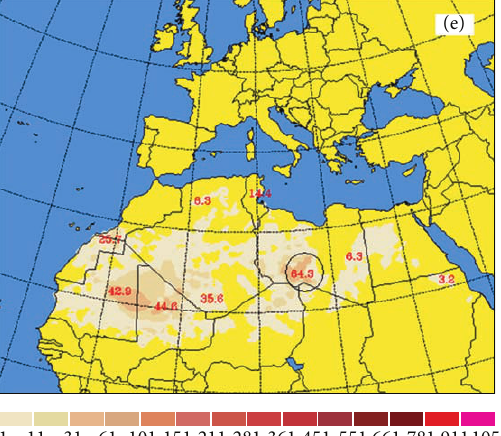
Figure 6: Dry deposition on 3 March 2004 at 18 UTC, (a) total dry deposition, (b) clay particle, (c) small silt particle, (d) large silt particle, and (e) sand